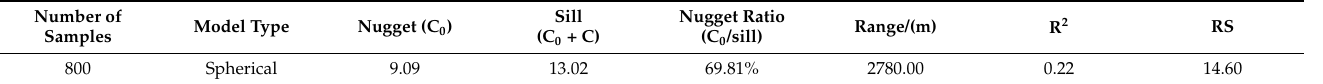
Table 3. The semivariance model of SOM content at 800 sample points and its fitting parameters.